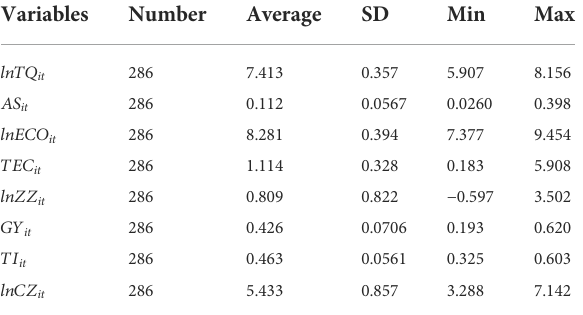
TABLE 4 Description of statistical analysis of variables.